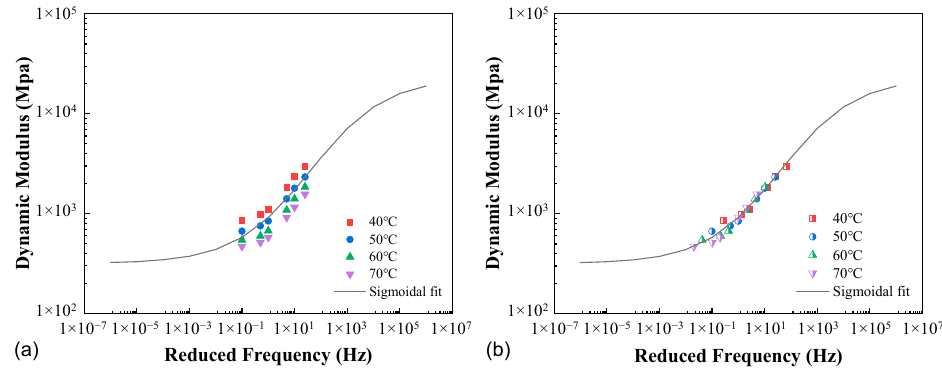
Figure 7. Application of the time–temperature superposition (AC-20, K = 94.3%, T R = 50 °C): ( a ) before and ( b ) after the horizontal shift.